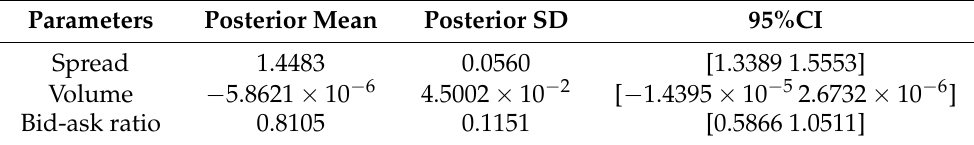
Table 9. Estimated parameters about limit order book (23 June 2016, TMC, Aichi, Japan). Parameters